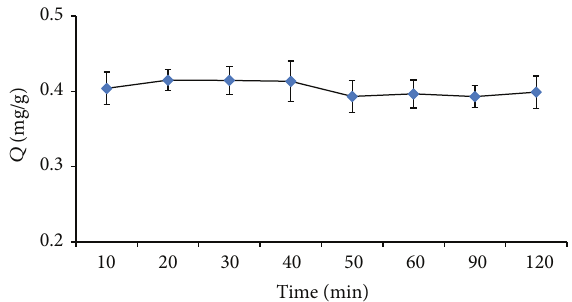
Figure 1: Effect of absorption time on the extraction efficiency ( 𝑄 ) of Sr 2+ . Extraction conditions: pH 7, 35 ∘ C, and stirring rate 600rpm.